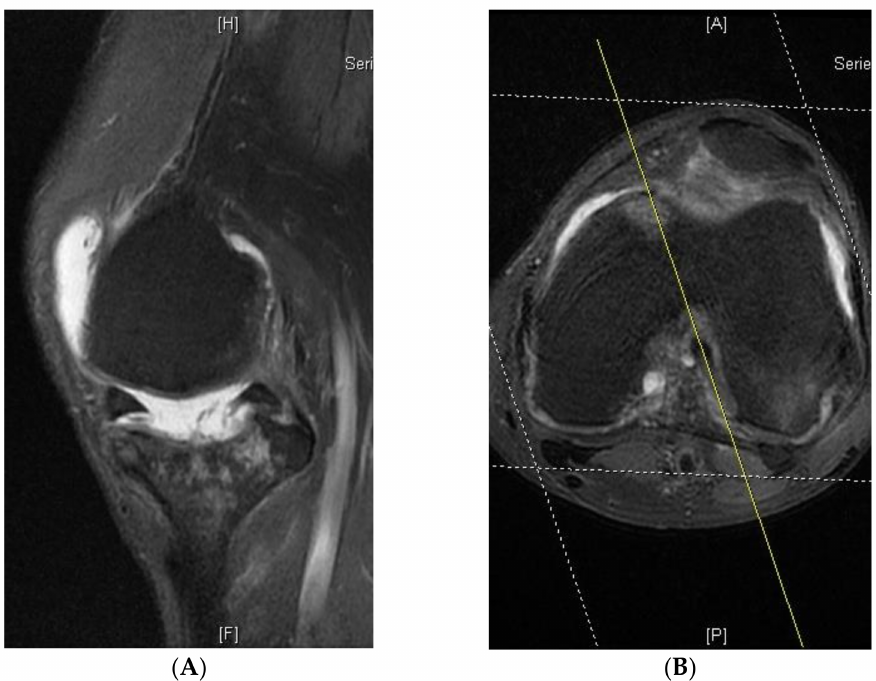
Figure 4. An unideal sagittal plane axis of magnetic resonance imaging would lead to incorrect measurement. ( A ) Sagittal cut of the MRI image. ( B ) Axial cut of the MRI image. The yellow line is the axis of the sagittal